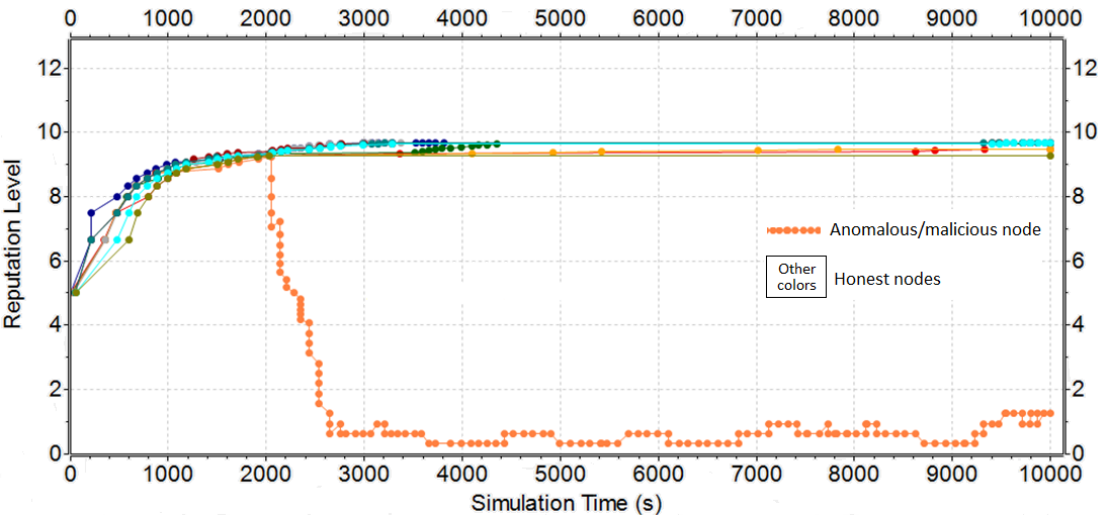
Figure 9. Reputation evolution for Inconsistency attack—Restricted Scenario.